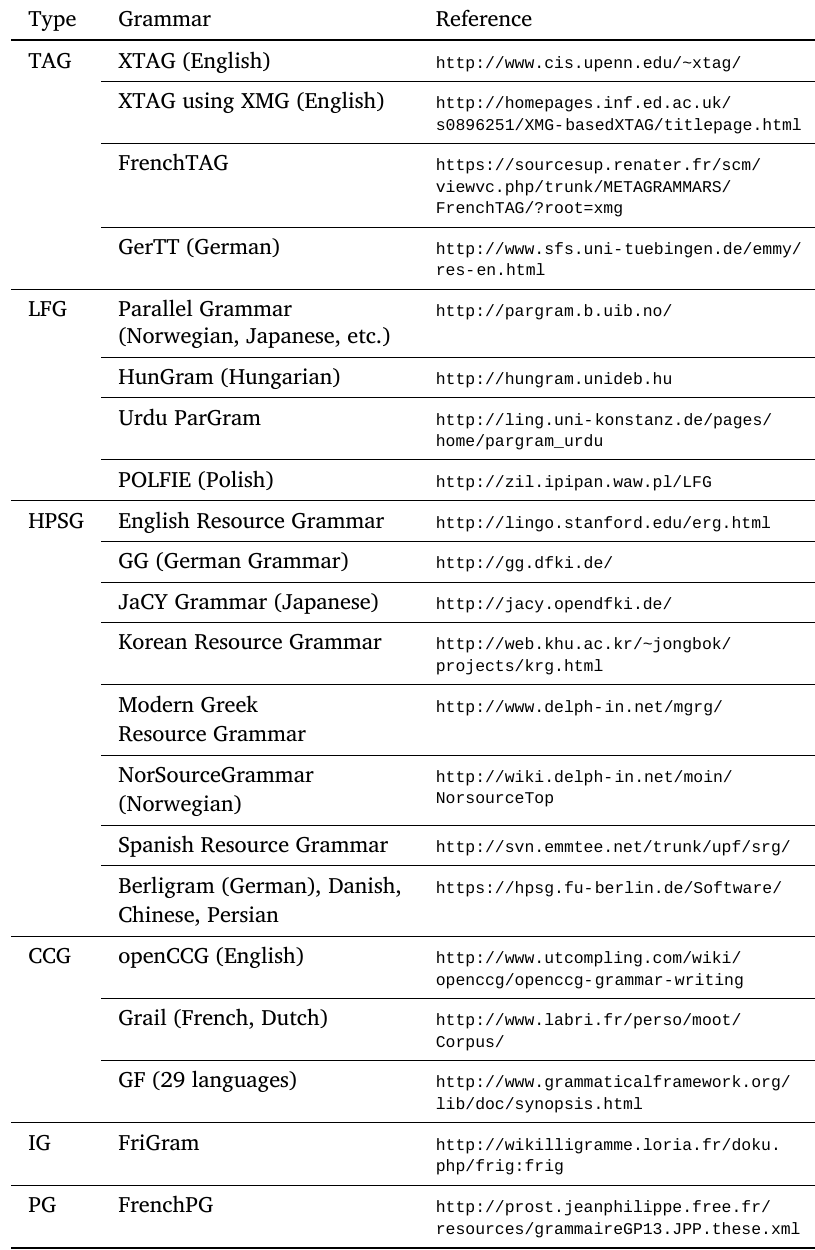
Table 1: Available electronic grammars (non-exhaustive)